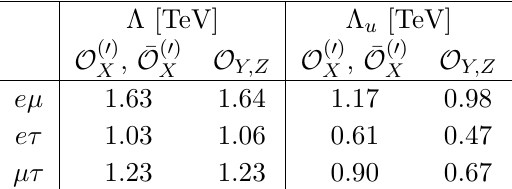
Table 1 . Lower limits on the scale for various operators with ((cid:3) u ) and without ((cid:3))